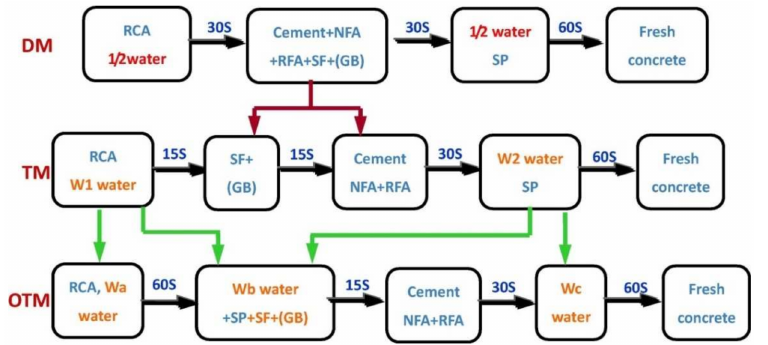
Figure 1. Comparison of mixing methods for the preparation of RAC [50] (Wa equals 60–80% of the product of the weight of RA multiplied by its water absorption, Wb equals the weight percentage of residual water of SCM in the total gelling material, and Wc = mixed water − Wb −